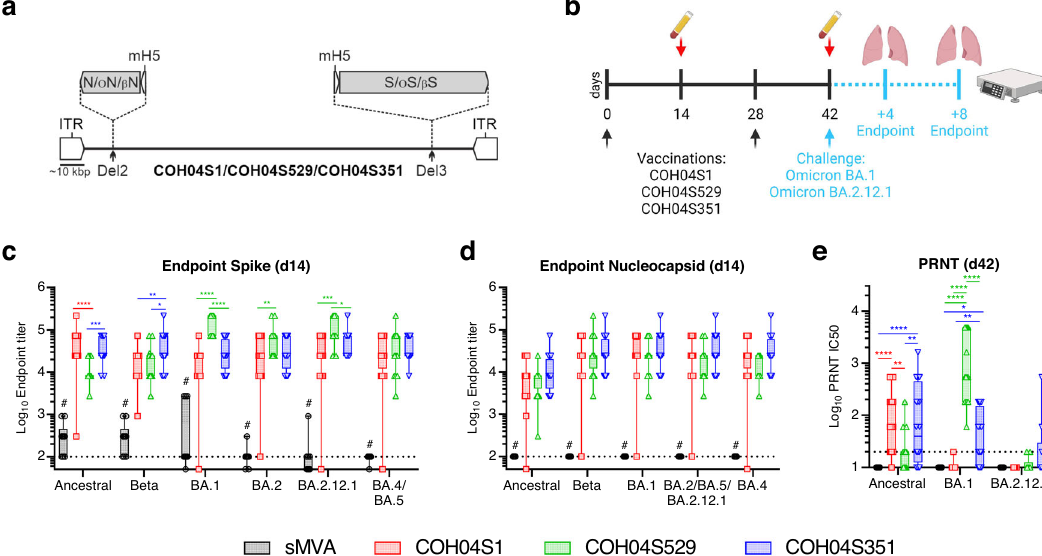
Fig. 1 COH04S1 and Omicron BA.1 and Beta sequence-modi fi ed vaccines elicit strain-speci fi c antibody responses against SARS-CoV-2 ancestral virus and VOC. a . Vaccine constructs. COH04S1, COH04S529, and COH04S351 are sMVA-vectored COVID-19 vaccines co-expressing S and N antigens based on the Wuhan-Hu-1 reference strain or Omicron BA.1 ( Ο ) or Beta ( β ) variants, respectively. The antigen sequences were inserted into the MVA deletion sites 2 (Del2) and 3 (Del3) as indicated. b . Study design. Hamsters were vaccinated twice with COH04S1 ( n = 20), COH04S351 ( n = 20), or COH04S529 ( n = 20) by intramuscular route as indicated (black arrows). Hamsters vaccinated with empty sMVA vector ( n = 10), or unvaccinated hamsters ( n = 10) were used as controls. Blood samples were collected at day 14 and 42 (red arrows) after the fi rst and second vaccination. COH04S1-, COH04S529-, and COH04S351-vaccinated hamsters were challenged intranasally at day 42 with Omicron subvariants BA.1 or BA.2.12.1 ( n = 10/group). sMVA control animals were challenged with BA.1. Unvaccinated controls were challenged with BA.2.12.1. Post-challenge body weight changes were recorded daily for 8 days. Lung tissue and nasal turbinates for viral load measurements and lung histopathology were collected at days 4 and 8 post-challenge ( n = 5/group/timepoint). IgG endpoint titers. S-speci fi c ( c ) and N-speci fi c ( d ) binding antibody titers to ancestral virus, Beta and Omicron subvariants BA.1, BA.2, BA.2.12.1, BA.4, and BA.5 were measured in serum samples of vaccine and control groups at day 14 (d14) post-prime vaccination via ELISA. Dotted lines indicate lower limit of detection (LLOD). # indicates signi fi cantly higher IgG titers in vaccine groups compared to controls. e . NAb titers. NAb titers were measured in serum samples of vaccine and control groups at day 42 (d42) post-second vaccination via PRNT assay against ancestral SARS-CoV-2 (WA/01), and Omicron BA.1 and BA.2.12.1. Dotted line indicates LLOD. Values below the LLOD are indicated as half the LLOD. Data are presented as box plots extending from 25th to 75th percentiles, with lines indicating medians, and whiskers going from minimum to maximum values. Two- way ANOVA with Tukey ’ s multiple comparison test was used in c-e following log transformation. *0.05 < p < 0.01, **0.01 < p < 0.001, ***0.001 < p < 0.0001, **** p < 0.0001. When not indicated, differences are not signi fi cant ( p >